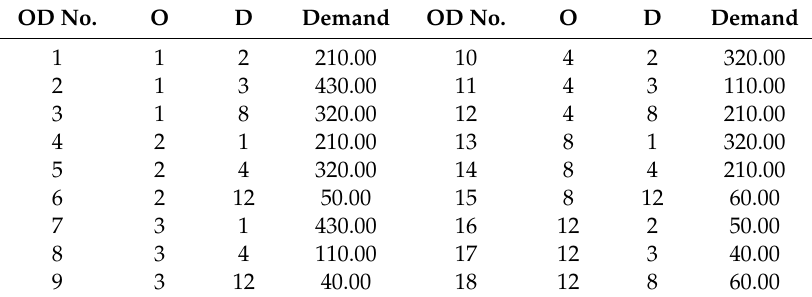
Table 7. Origin–Destination (OD) pairs and the corresponding